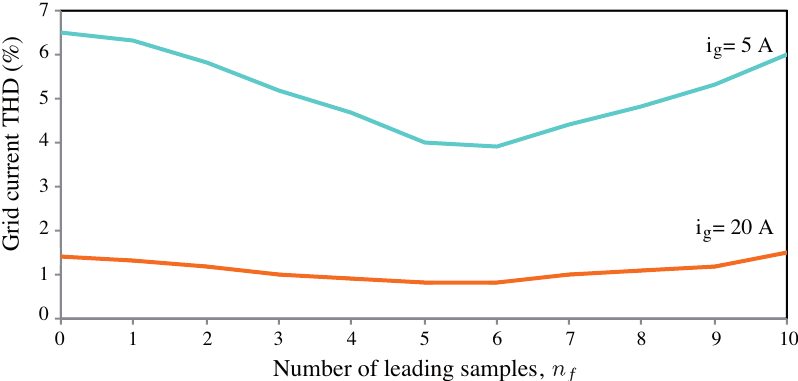
Figure 13. Grid current THD as a function of the estimation leading samples ( n f ) using the CCF schema and the CE